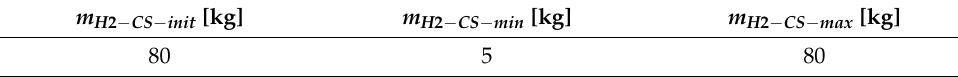
Table 4. Data of common hydrogen storage unit.